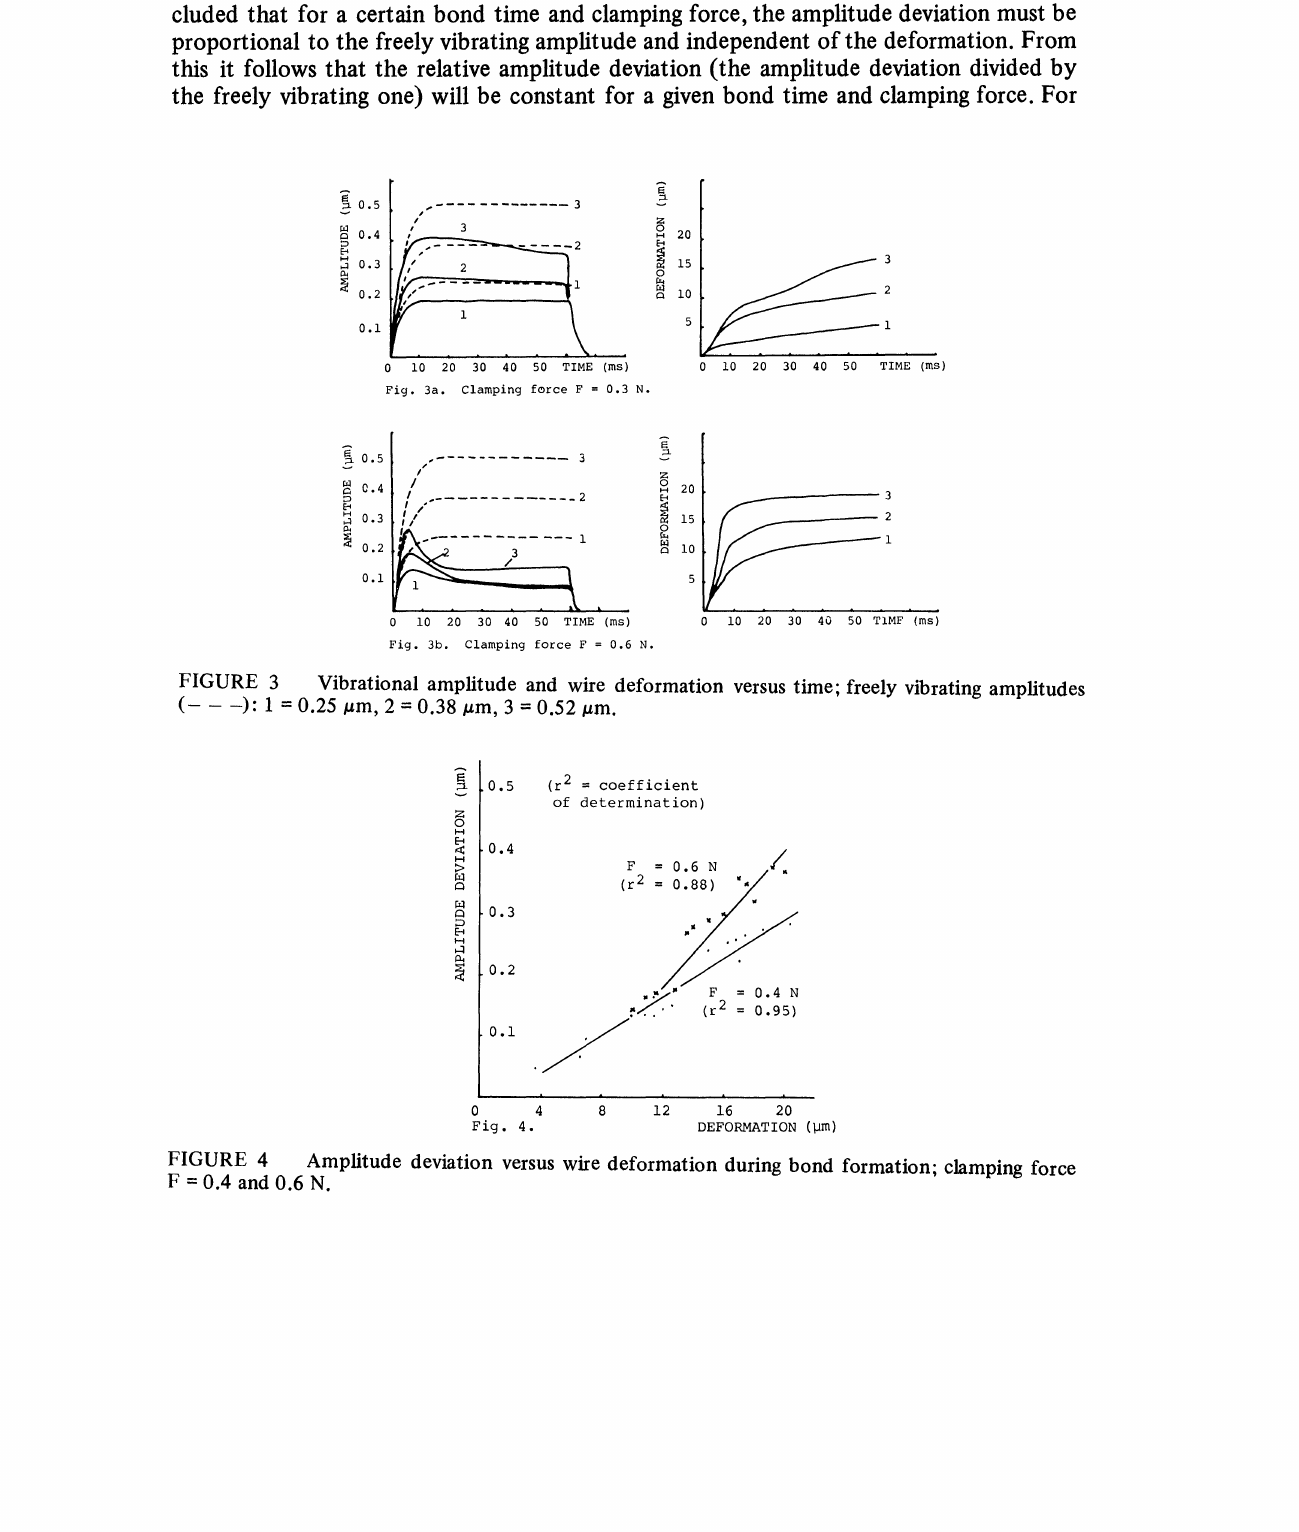
Amplitude deviation versus wire deformation during bond formation; clamping force F 0.4 and 0.6